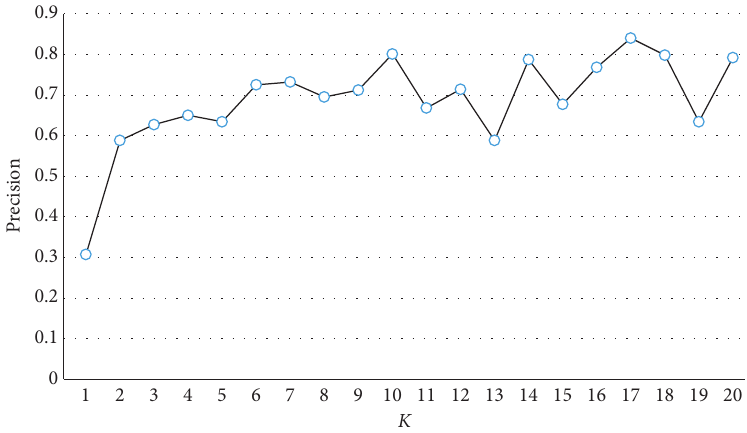
Figure 9: Changes in classification precision under different K values. Table 2: Example of signal equipment fault